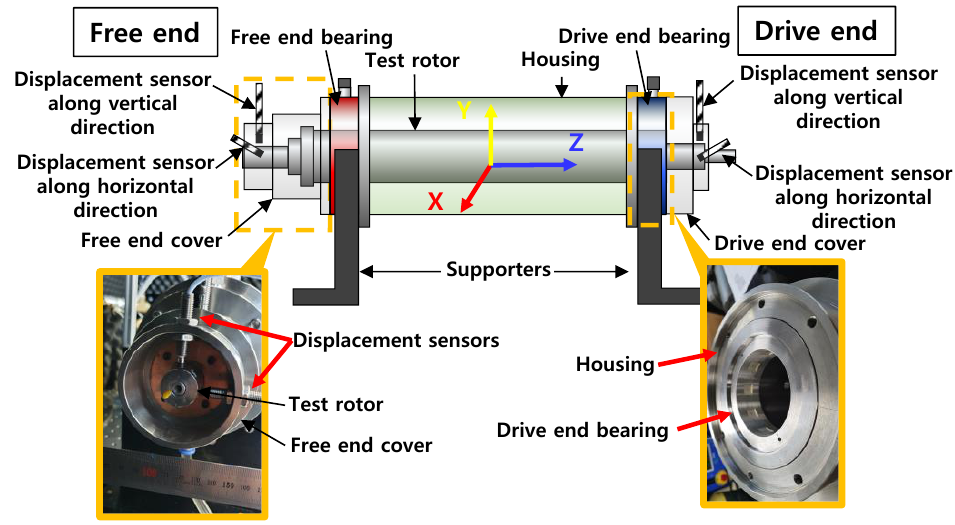
Figure 1. Schematic view (not to scale) and photographs of current test rig.